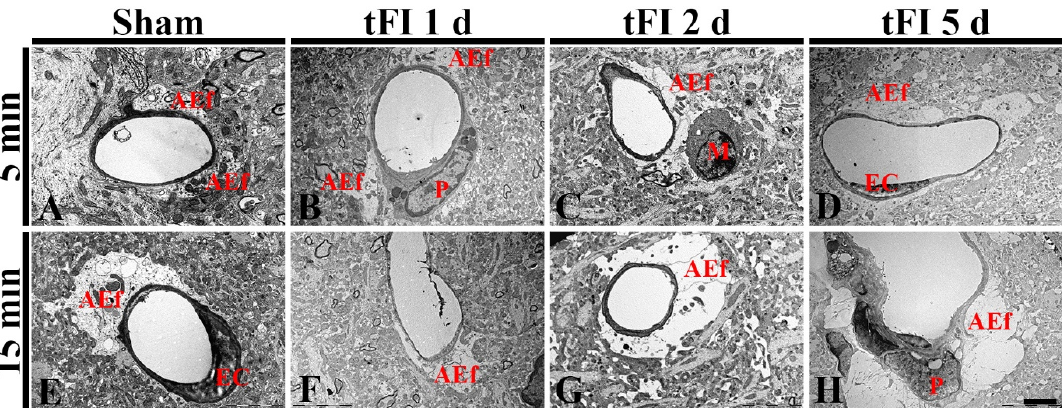
Figure 8. Electron micrographs of AEf around a blood vessel using TEM in the mild sham ( A ), mild tFI ( B – D ), severe sham ( B ), and severe tFI ( F – H ) groups at one day ( B , F ), two days ( C , G ) and five days ( D , H ) after tFI. In both sham groups, AEf has many mitochondria and surrounds the basal membrane of endothelial cells (EC). AEf becomes damaged with time after tFI: in the severe tFI group, the damage is more significant. On day 5 after tFI, AEf looks like a vacuole and no mitochondria were in both groups: in the severe group, EC and pericyte (P) are severely damaged. Scale bar = 2.5 μ m.